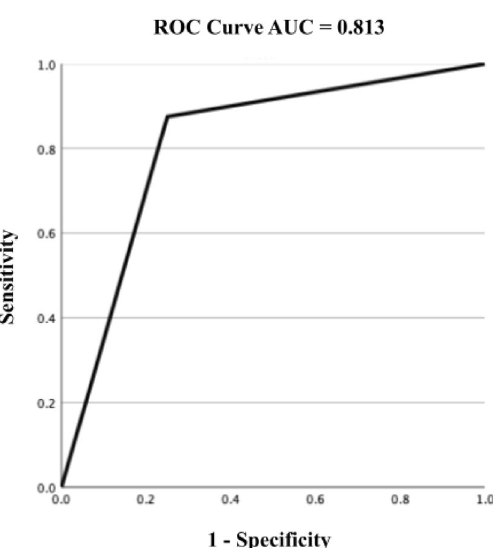
Figure 5. Receiver operating characteristic curve for DED diagnosis by the AI model and EMR. The area under the curve of the receiver operating characteristic curve for DED diagnosis by the AI model and EMR was 0.813 (95% CI